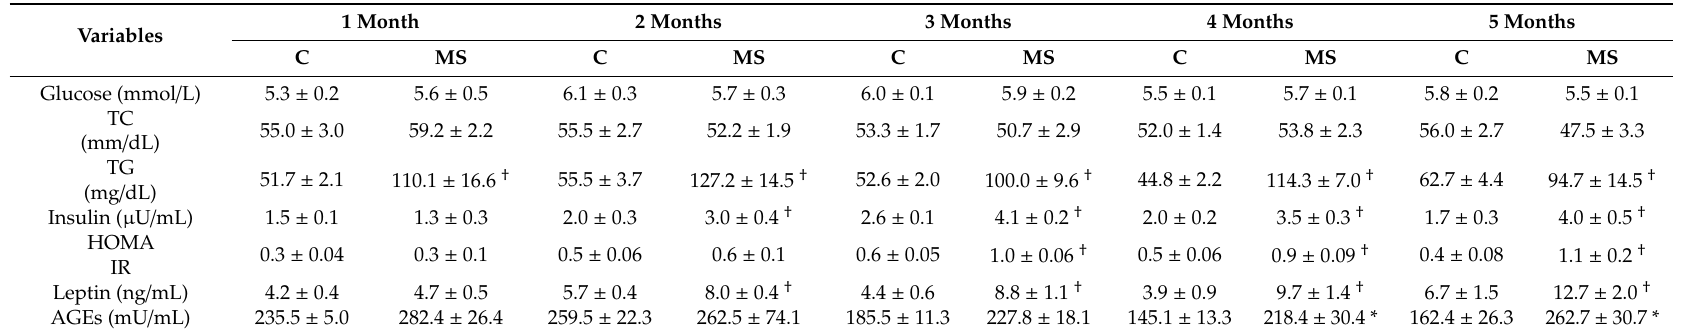
Table 2. Biochemical blood characteristics in experimental